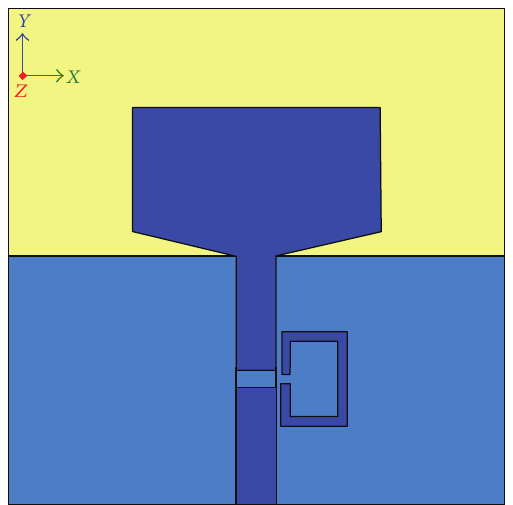
Figure 6: Integration of the OLR-based bandpass filter into the wideband antenna.